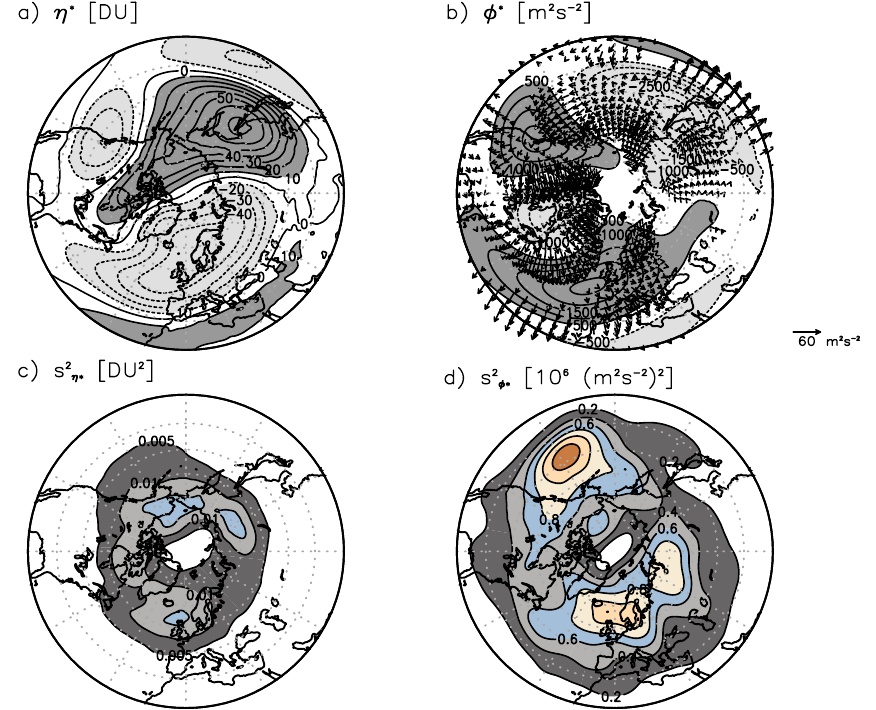
Figure 1. Climatological mean of ( a ) zonally asymmetric total ozone (ZATO) [DU] and of the ( b ) geopotential disturbance [m 2 s − 2 ] at 300 hPa for January 1980–2016. The variances are shown for ( c ) ZATO [DU 2 ] and for ( d ) the geopotential disturbance [m 4 s − 4 ]. Additionally, arrows in ( b ) indicate the wave activity flux vector according to [33] in [m 2 s − 2